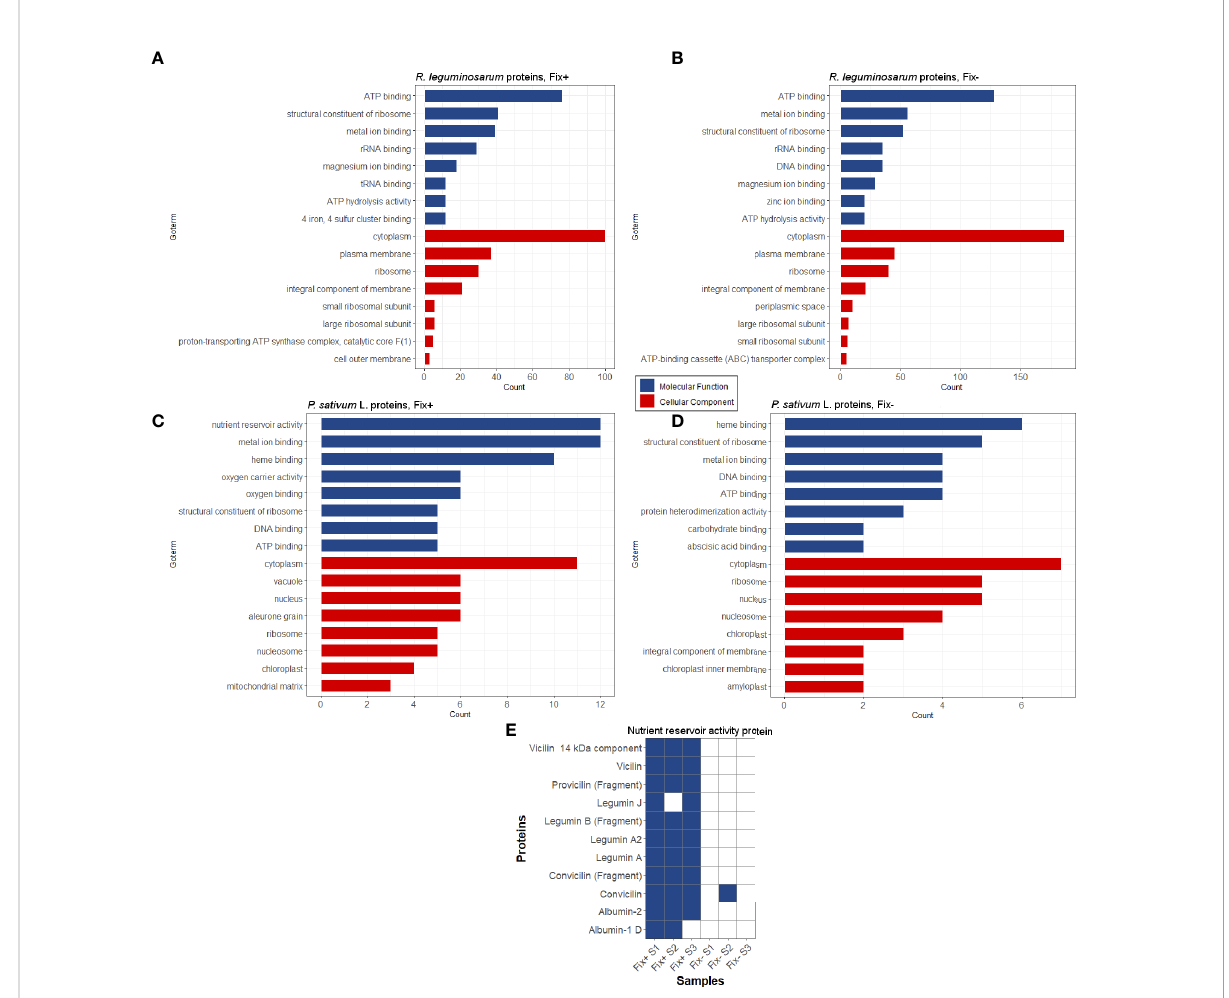
FIGURE 4 Potentially amyloidogenic proteins of Fix + and Fix - root nodules formed by R. leguminosarum (A) and (B) , P. sativum L. (C) and (D) , respectively. Top-8 GO annotations of “ Molecular Processes ” and “ Cellular Component ” categories of identi fi ed proteins based on UniProt data are shown. (E) Potentially amyloidogenic proteins of P. sativum L. with “ nutrient reservoir ” activity identi fi ed in protein samples obtained from wild-type and sym31 mutant nodules. Proteins identi fi ed in particular samples (S1-S3) and Fix status of nodules are